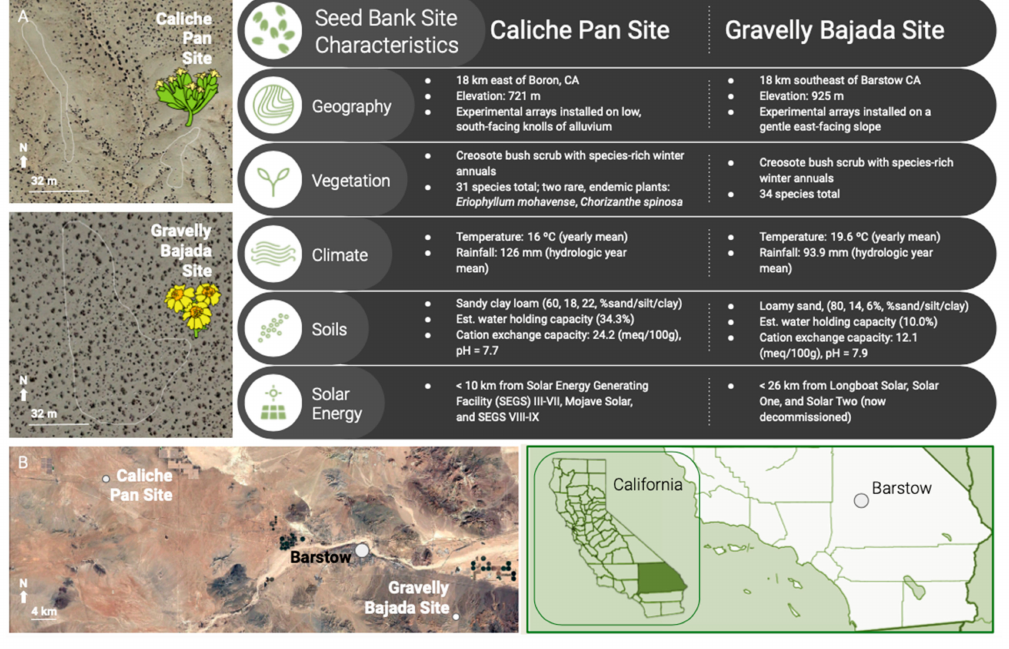
Figure 5. Site-level maps and characteristics of the Caliche Pan and Gravelly Bajada Sites (Western Mojave Desert, CA, USA; A. Google Earth, 222 m alt.; B. Landsat / Copernicus, 721 m